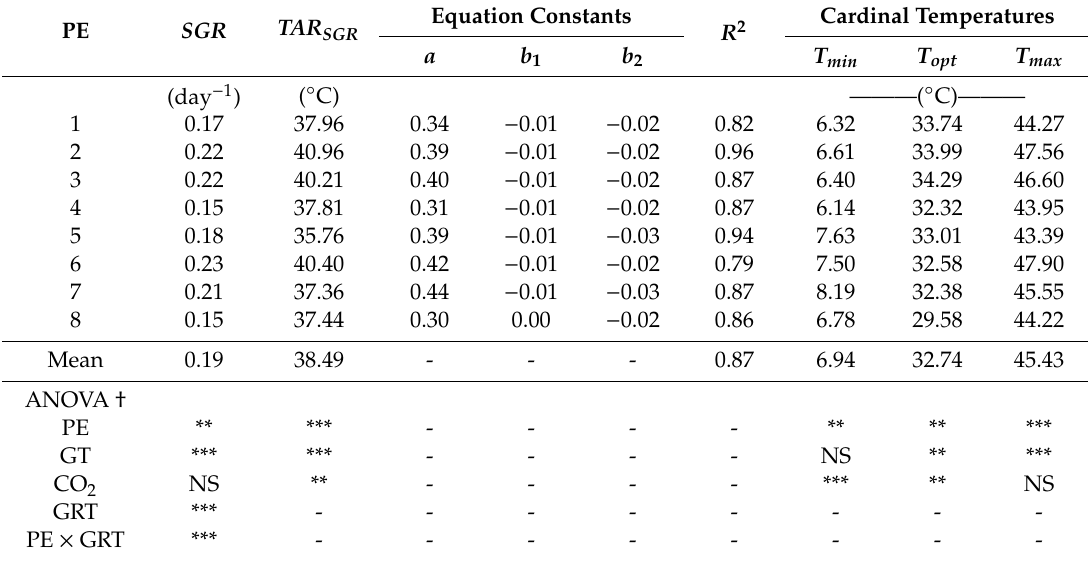
Table 3. Seed germination rate ( SGR ), temperature adaptability range for seed germination rate ( TAR SGR ), modified bilinear equation constants ( a , b , and c ) and cardinal temperatures ( T min , T opt , and T max ) for the SGRs of big bluestem seeds grown from eight parental